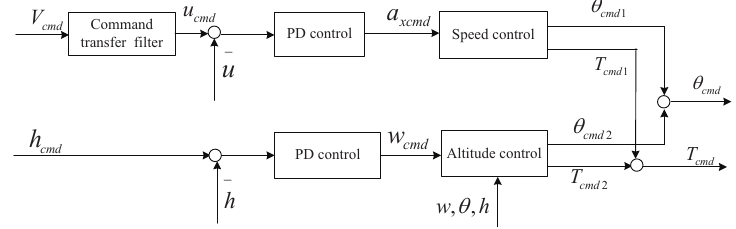
Figure 11. Outer loop control block diagram in conversion flight